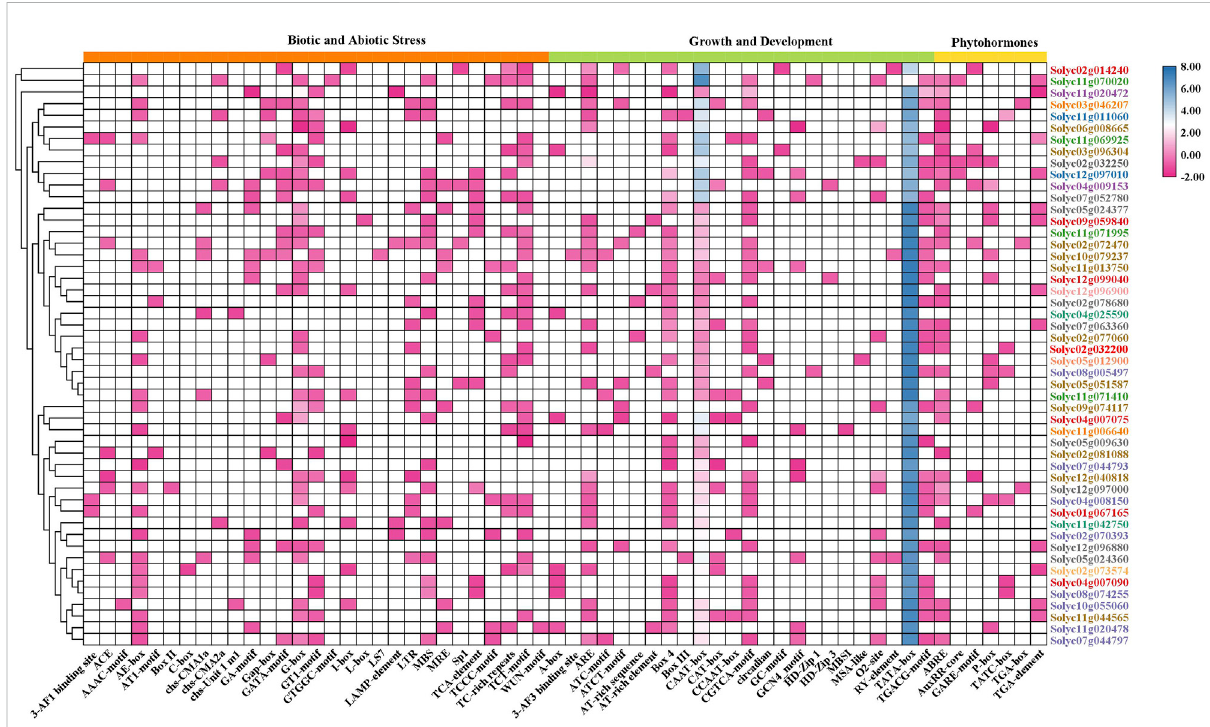
FIGURE 3 Cis-regulatory elements in the promoter regions of tomato NLRs and their distribution among biotic and abiotic stresses, growth and development, and phytohormones. The NLR genes are listed on the right side in different colors according to subfamily.The legend color pattern of the heatmap indicates the abundance of CREs among the NLR